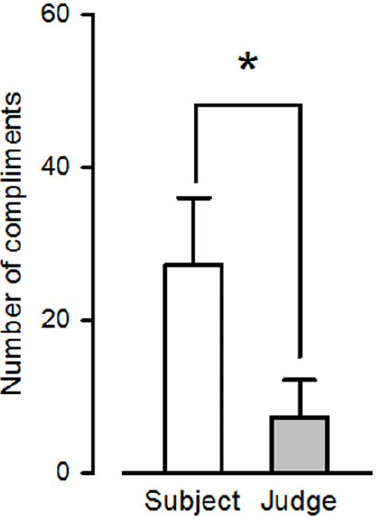
Figure 1. Number of compliments. Number of compliments that the subjects and the judges gave each other when the subjects were perceived as humans, p , .05 (Student paired t-test).